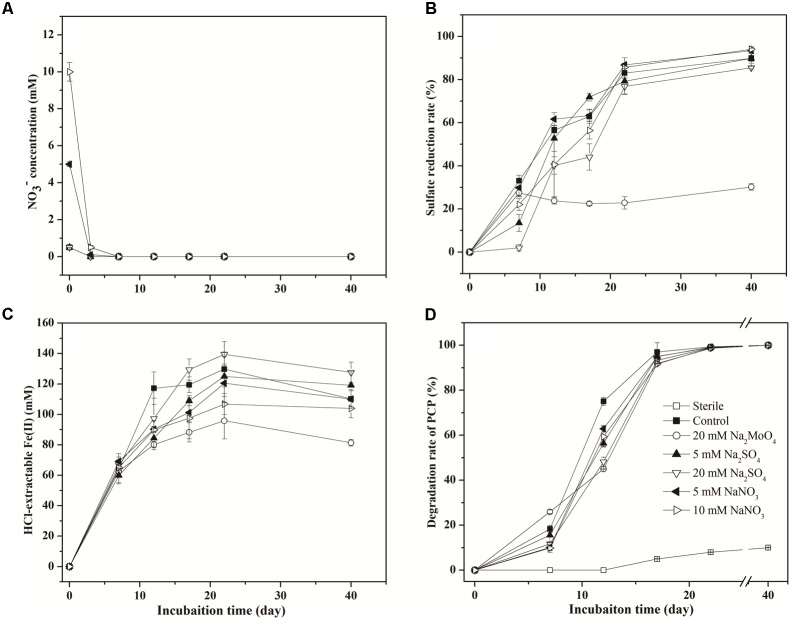
Dynamics in the concentration of NO3−
(A), SO42−
(B), HCl-extractable Fe(II) (C), and PCP (D) in different treatments.